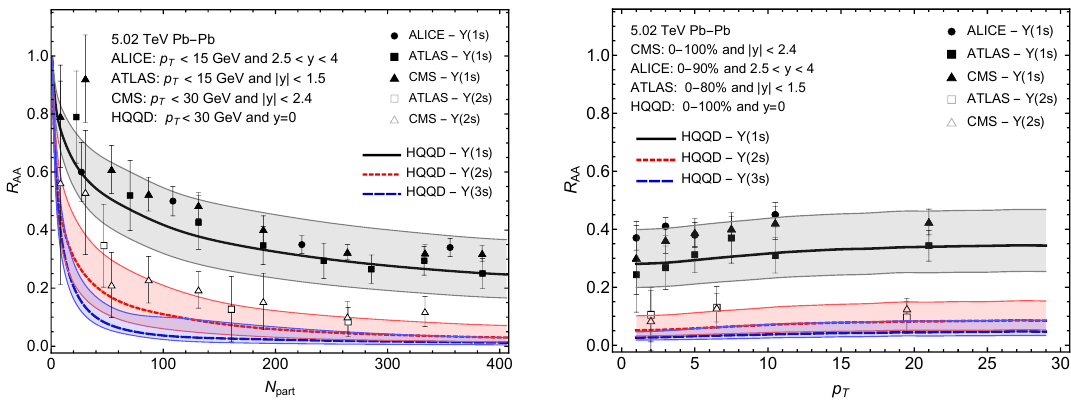
Figure 1 . Nuclear suppression factor, R AA , of bottomonium s -wave states as a function of N part (left) and p (right). The solid, short-dashed, and dashed lines show the predictions of HQQD. T The shaded bands indicate the variation of the HQQD result when changing the model parameters in the range specified in eq. (6.1). The data points are from the ALICE [78], ATLAS [79], and CMS [71] collaborations. Experimental error bars shown were obtained by adding statistical and systematic uncertainties in